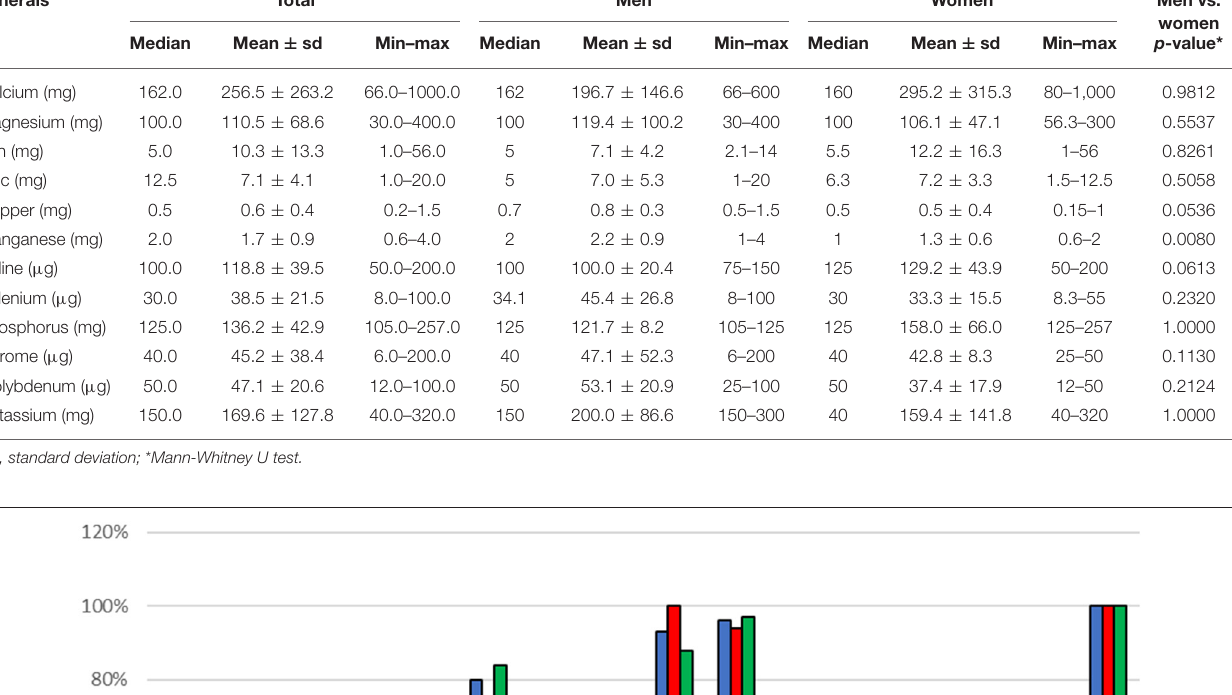
TABLE 4 | Intake of minerals from food supplements. Minerals